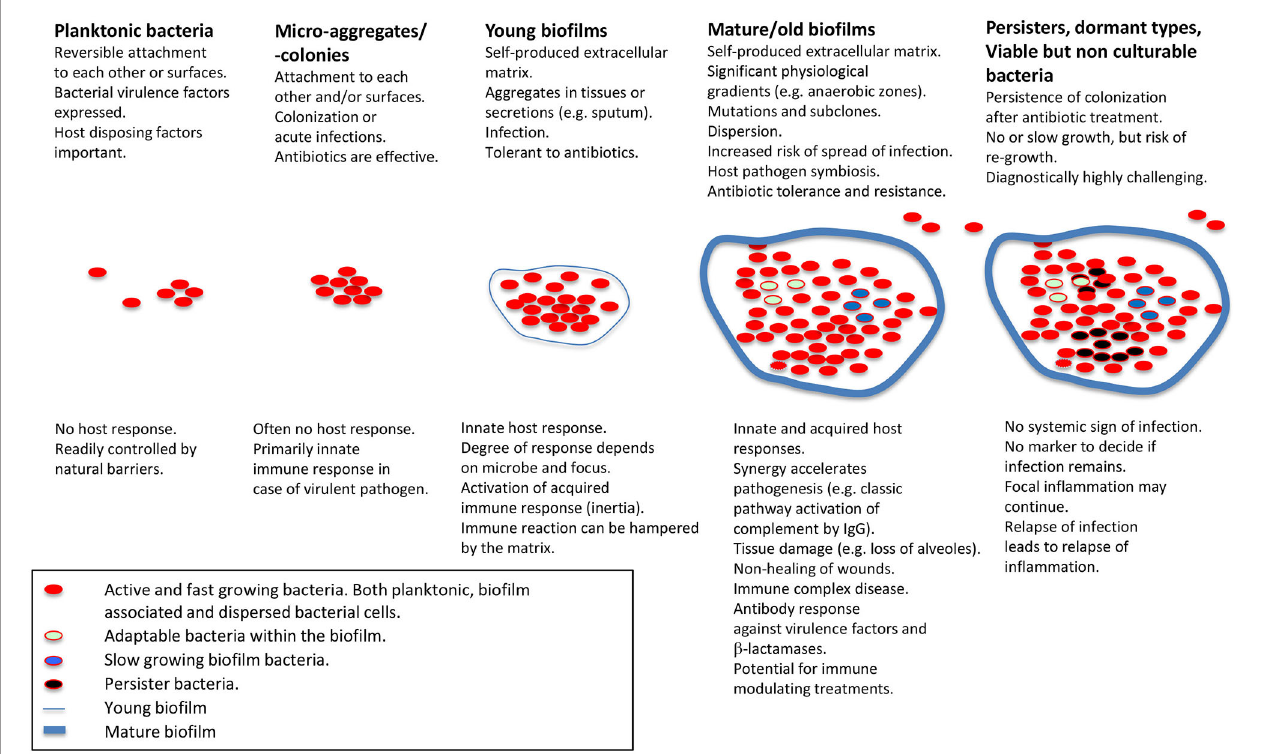
FIGURE 1 | Schematic presentation of bio fi lm stages and host response. Applies for non-foreign body-related bio fi lm infections, which is the main focus of the present review. Modi fi ed from Moser et al. (5) with permission from John Wiley & Sons,